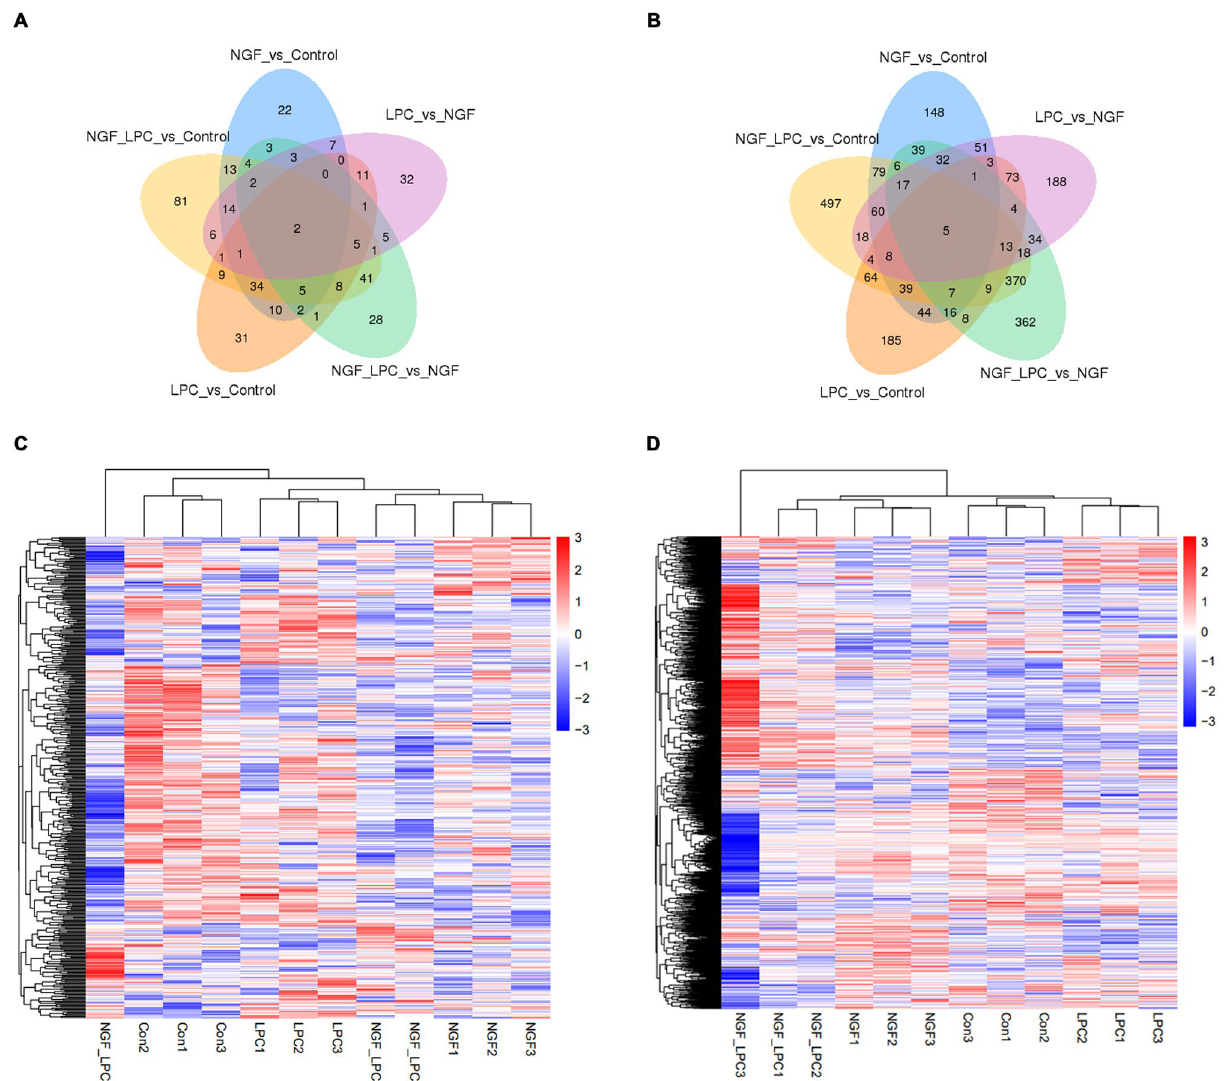
Figure 4. mRNAs and lncRNAs profiles from cells under different treatments and showed in Venn diagram and Heatmap analysis. ( A , B ): Venn diagram for mRNA and lncRNA pieceful. ( C , D ): Heatmap analysis for all differentially expressed mRNAs and